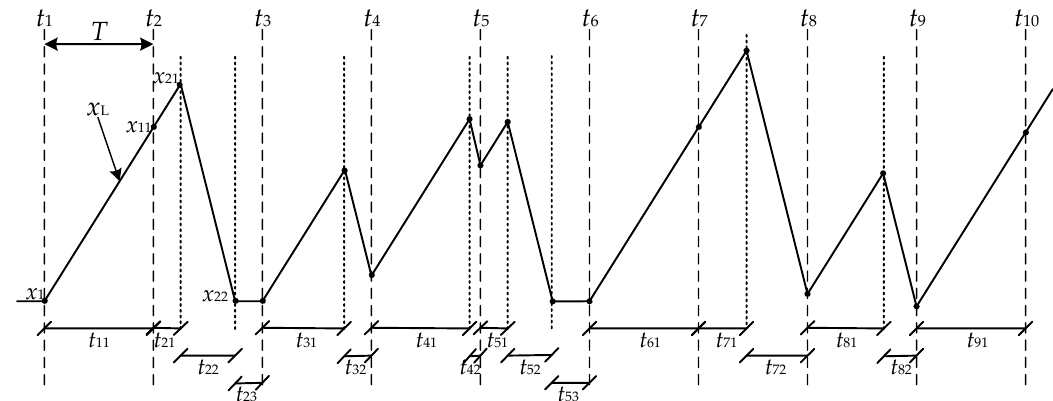
Figure 1. Sampling at the mode switching time to build a mode switching time sequence (MSTS.)